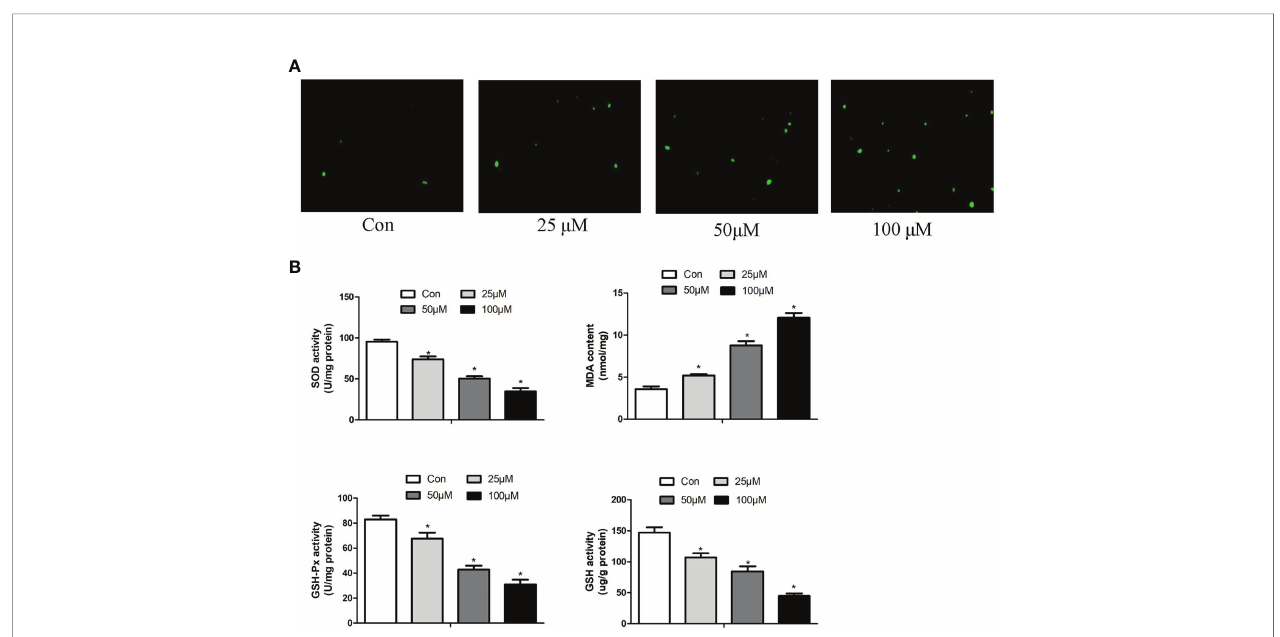
initiating autophagy and Th1/Th2 imbalance. Figure 6 presented the results obtained from the expression of 25 selenoproteins on treatment of Sch B at 0, 25, 50, and 100 µM, respectively. Txnrd1, Txnrd2, Txnrd3, GPX1, GPX2, Dio1, Dio2, Dio3, GPX6, Selt,